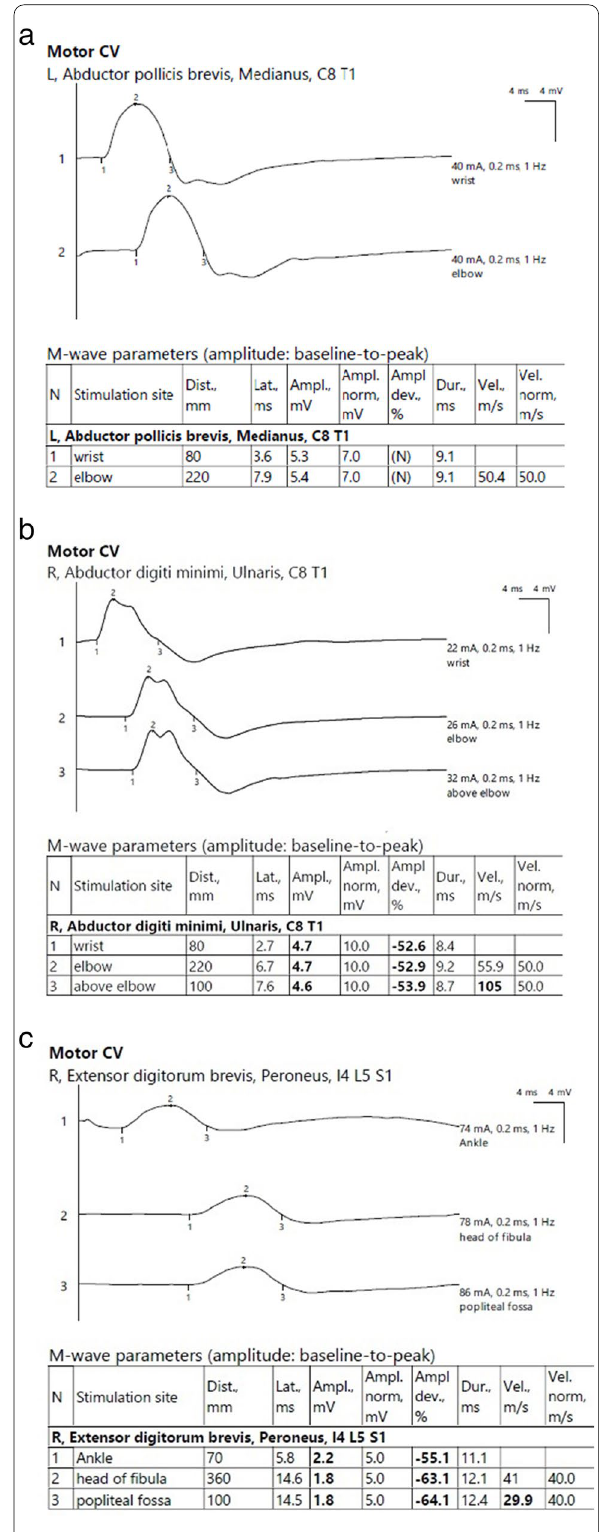
Fig. 4 a Normal electrophysiological study of left median nerve after 4 months of treatment. b Normal electrophysiological study of right ulnar after 4 months of treatment. c Normal electrophysiological study of right common peroneal after 4 months of